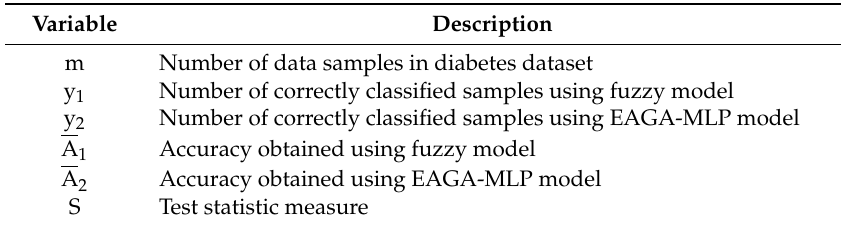
Table 22. Parameters for Statistical hypothesis analysis.